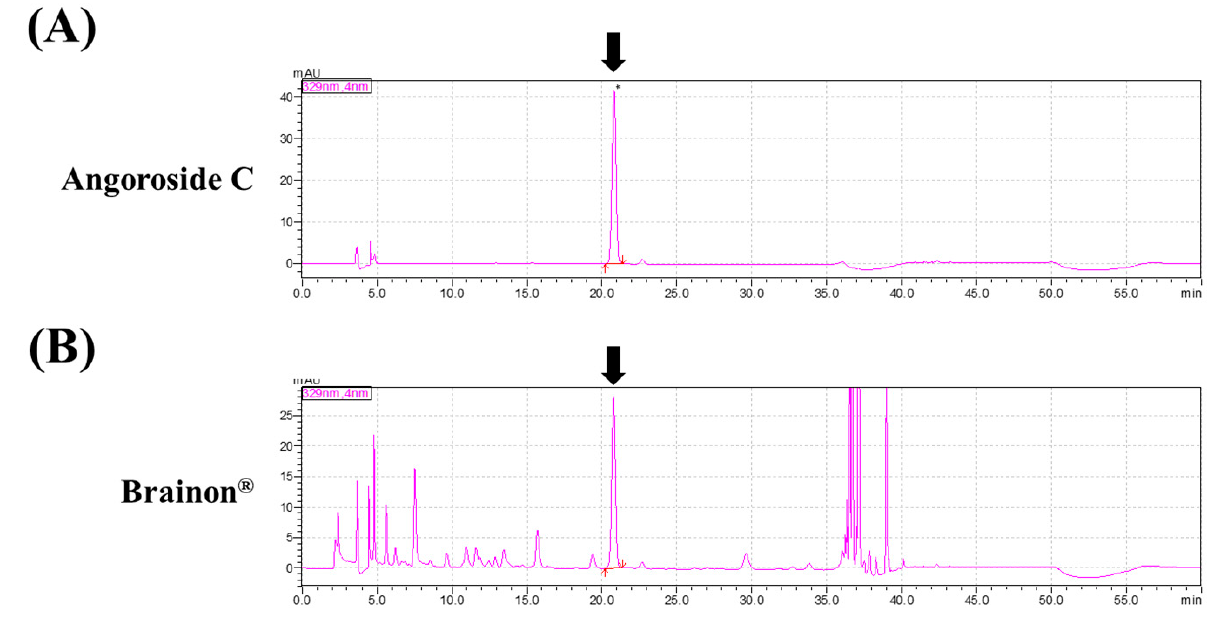
Figure 1. Composition of Brainon ® . High-performance liquid chromatography (HPLC) chromato- gram of Angoroside C and Brainon ® . HPLC chromatogram of ( A ) Angoroside C (standard) and ( B ) Brainon ® . The arrow indicates the peak for Angoroside C.